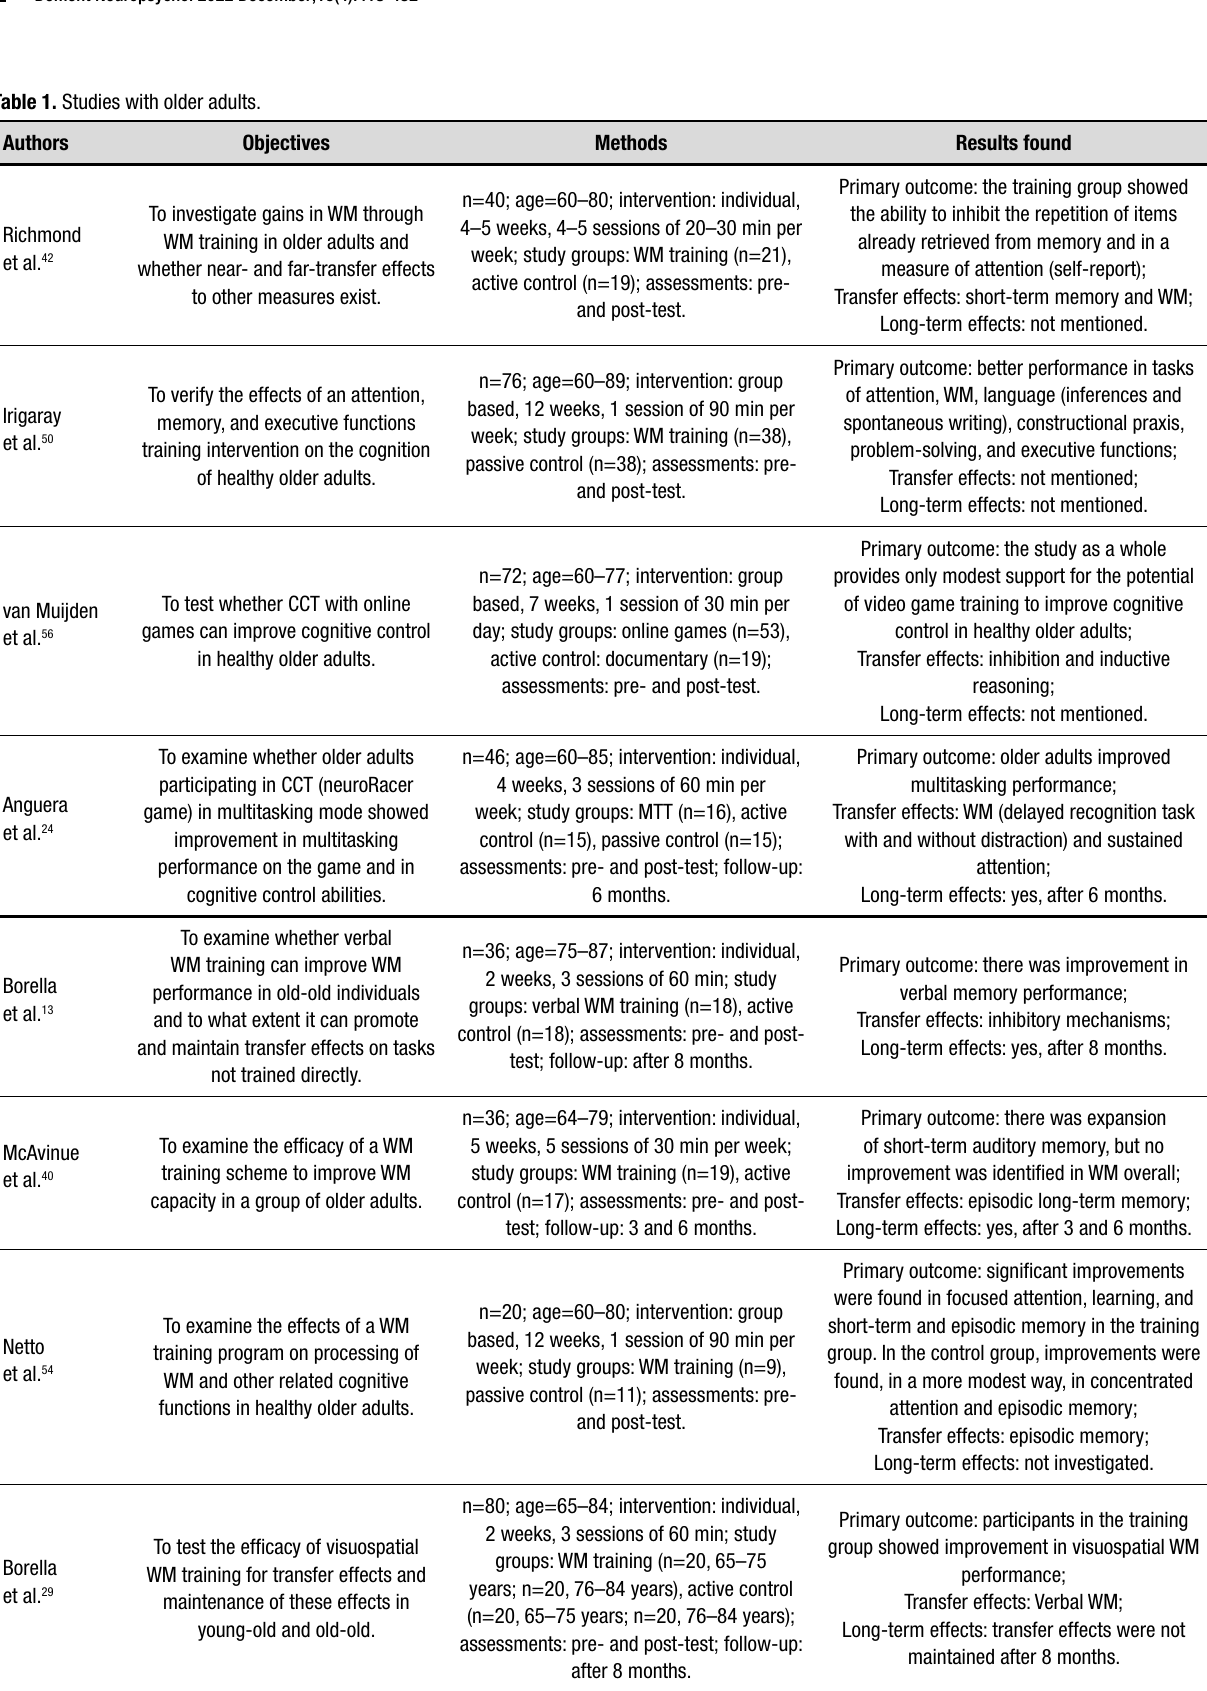
Table 1. Studies with older